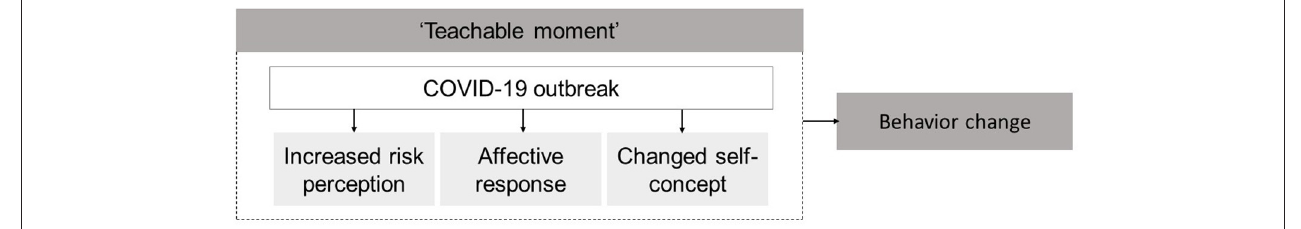
FIGURE 1 | Conceptual framework based on McBride et al.